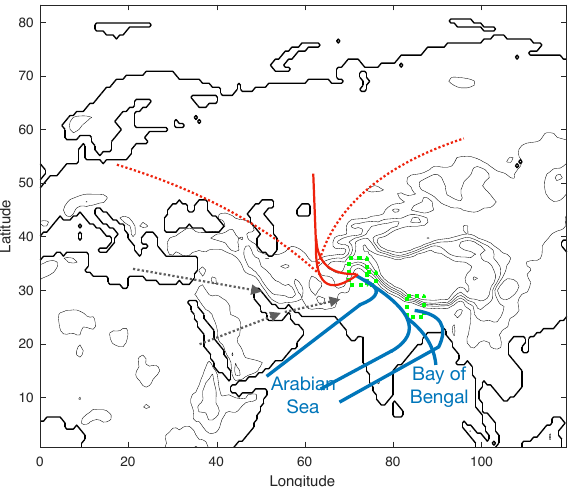
Figure 17. Schematic view of the parcel pathways during the monsoon season. Red dashed lines are the bounds for the main climatology for parcel back-trajectories originating from Eastern Europe and Russia. Gray arrows are for the winter. Solid blue are for the extreme events